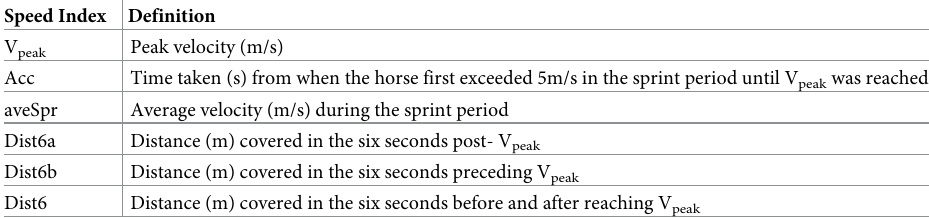
Table 4. Definitions of speed indices derived from GPS measurements used for the development of principal